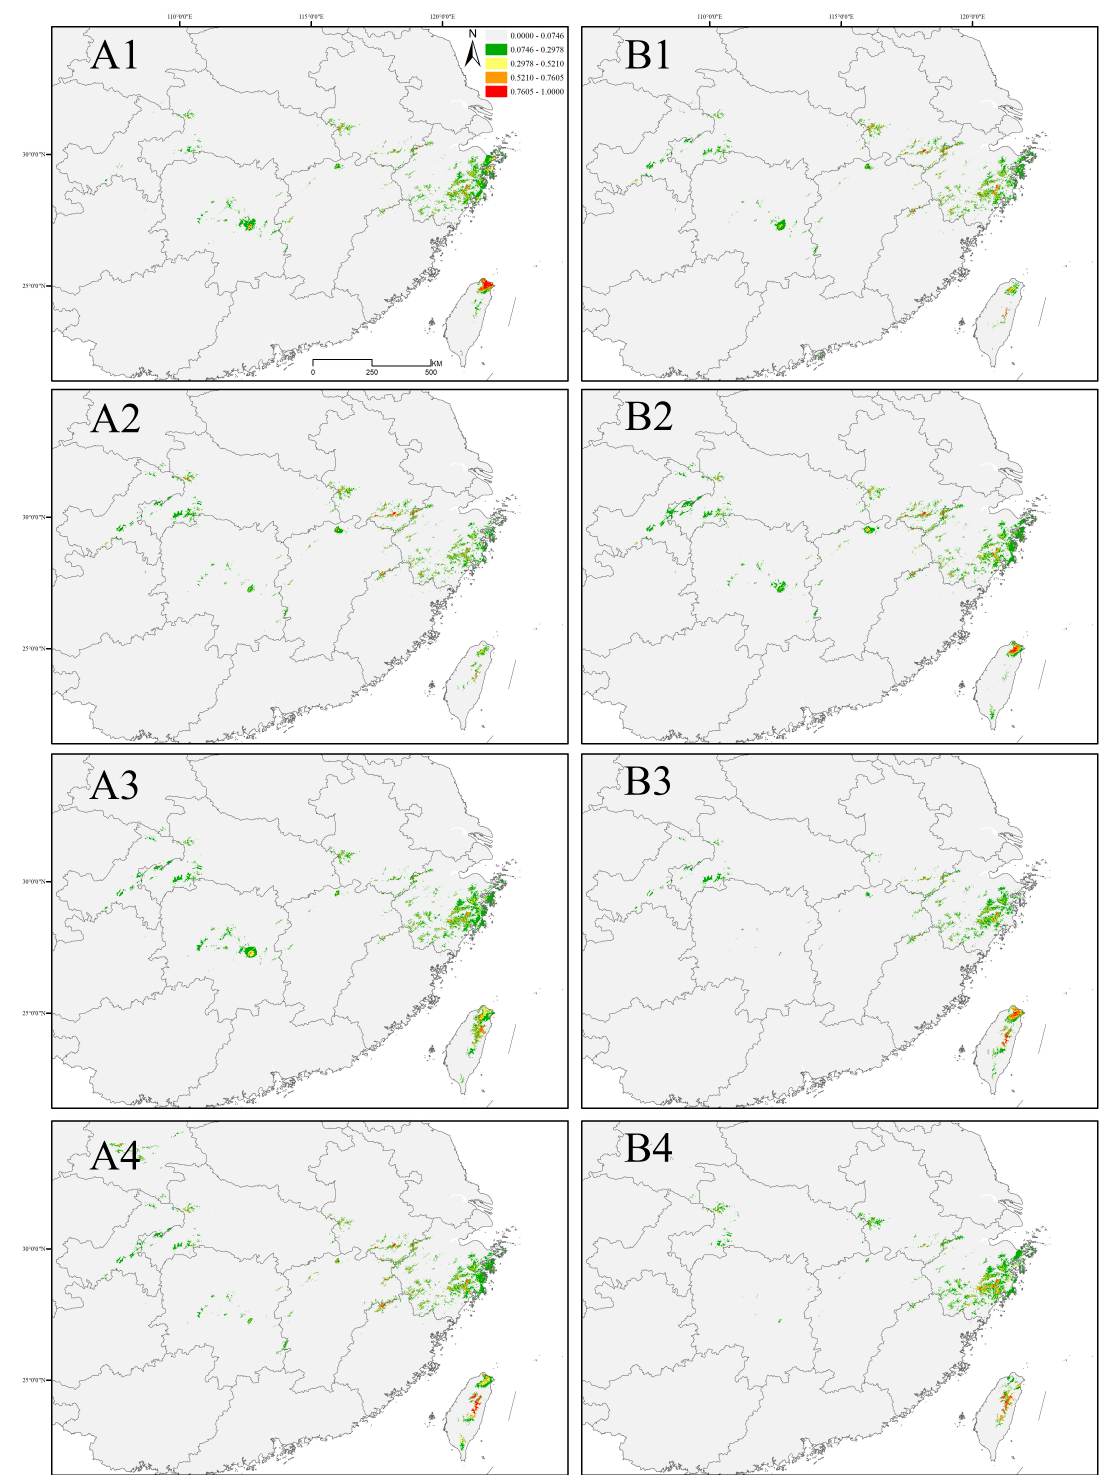
Figure 5. Suitable distribution areas of Carpinus tientaiensis in future climate change scenarios. ( A1 – A4 ), the 2050s; ( B1 – B4 ), the 2070s; 1, future climate scenario RCP 2.6; 2, future climate scenario RCP 4.5; 3, future climate scenario RCP 6.0; 4, future climate scenario RCP